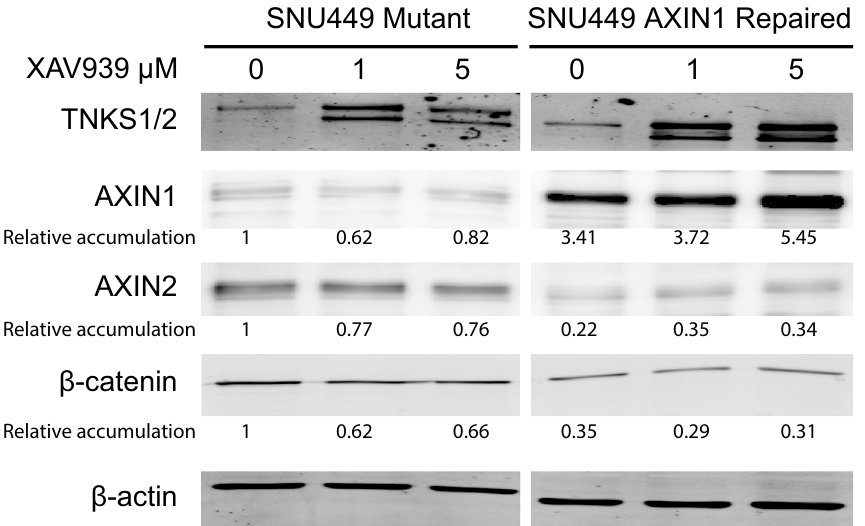
Figure 6. Evaluation of AXIN1-repaired SNU449 cells. At baseline (0 μM XAV939) the AXIN1-repaired SNU449 cells show increased levels of AXIN1, while AXIN2 and total β-catenin levels are decreased, indicating that AXIN1 contributes to increased β-catenin turnover. Following XAV939 treatment at indicated dosages, only a clear accumulation is observed for the AXIN1-repaired protein. For this experiment the AXIN1-repaired SNU449 clone-20 was compared with control clone-2. All relative band intensities are compared to this latter clone, which were arbitrarily set to